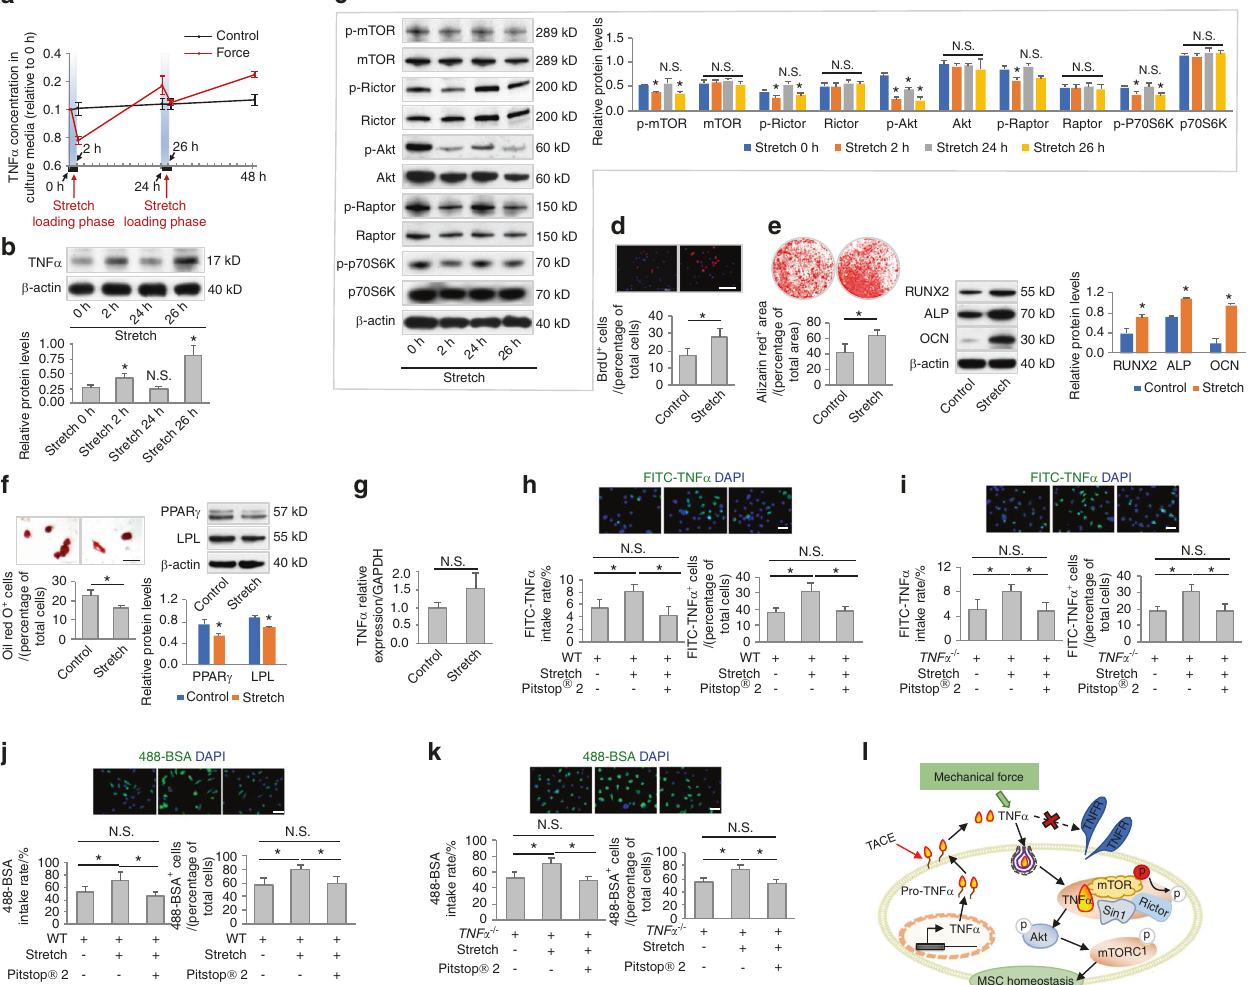
Fig. 5 Mechanical force drives TNF α endocytosis and promotes MSC function. a , b Examination of secreted concentrations and protein expression levels of TNF α . MSCs underwent cyclic loading of stretch force at 15% elongation, 0.5 Hz. N = 3. c Western blot analyses of mTOR signaling ( N = 3). d – f Functional analyses of MSCs according to BrdU labeling and osteogenic and adipogenic differentiation. N = 3. Scale bars = 100 μ m. Stretch force was applied twice per week for 2 h per session. g qRT-PCR analysis of the mRNA expression levels of TNF α ( N = 3). h , i Endocytosis analysis of FITC-labeled TNF α uptake by MSCs for 2 h in vitro. Pitstop ® 2 was used to inhibit clathrin-mediated endocytosis at 12 μ mol·L − 1 . Stretch force was applied for a 2 h period. N = 3. Scale bars = 20 μ m. j , k Endocytosis analysis of Alexa Fluor TM 488-conjugated bovine serum albumin (488-BSA) taken up by MSCs for 2 h in vitro. Pitstop ® 2 was used to inhibit clathrin-mediated endocytosis at 12 μ mol·L − 1 . Stretch force was applied for a 2 h period. N = 3. Scale bars = 20 μ m. l Diagram showing mechanical force-driven TNF α endocytosis. For quanti fi cation of Western blotting, a two-tailed Student ’ s t test was used for the comparison between the treatment and stretch 0 h/control groups. * P < 0.05. N.S. not signi fi cant. Data represent the mean ±